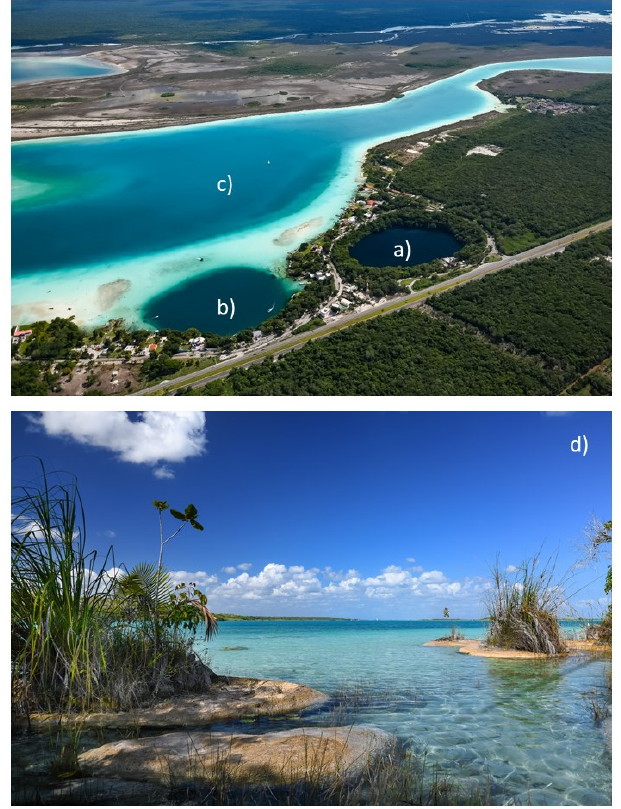
Figure 2. Examples of some sampled localities: ( a ) Cenote Azul, ( b ) Cenote Cocalitos, ( c ) Bacalar lake, and ( d ) large microbialites from Bacalar lake. Photos taken by ©HBahena/ECOSUR.